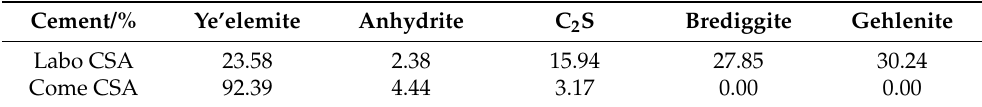
Table 2. Mineralogical composition of the CSA cements.